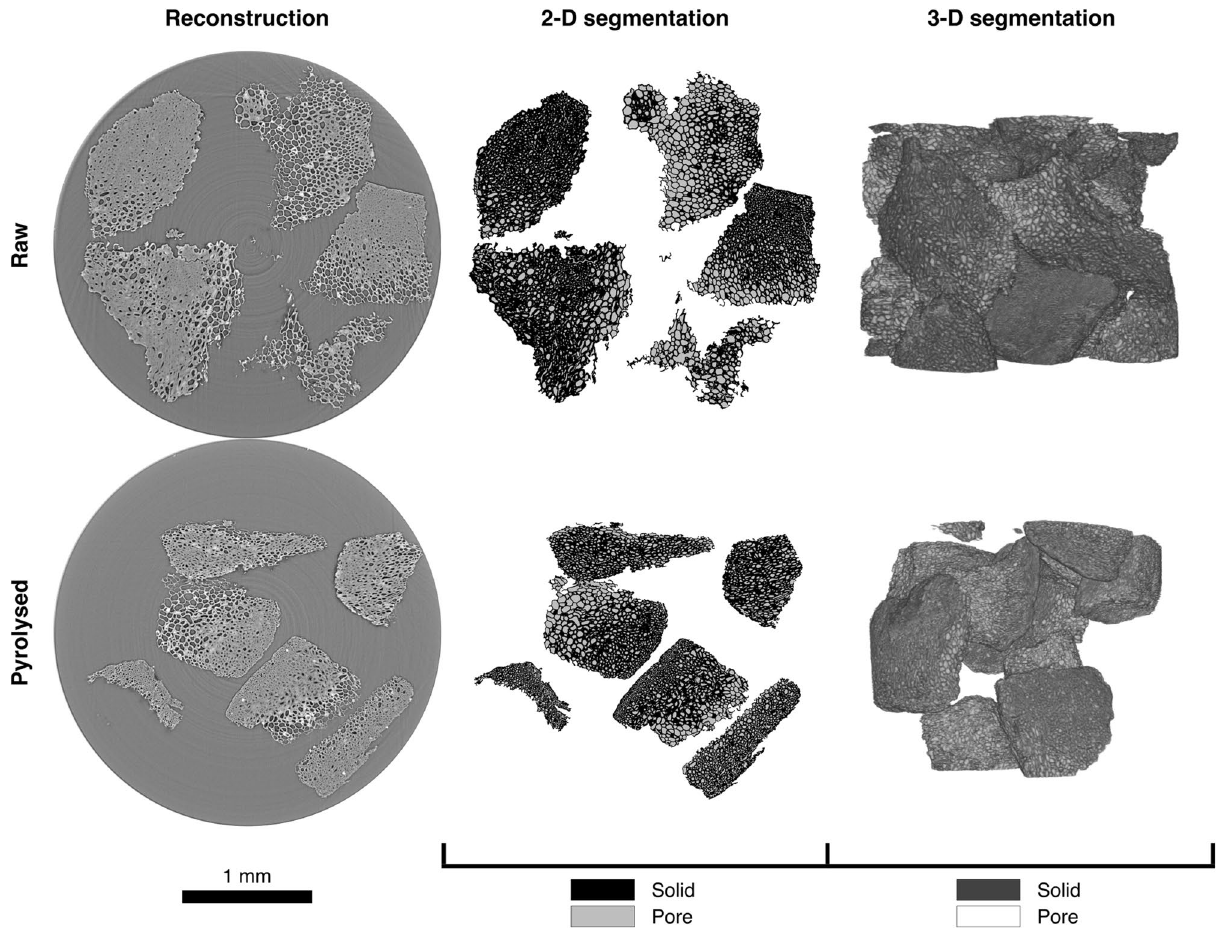
Figure 4. Reconstructed and segmented tomograms and corresponding three-dimensional (3-D) renderings of raw and pyrolysed water-soaked almond shells. Pyrolysed shells were heated at a rate of 6 °C min −1 to a peak temperature of 450 °C and held for 30 min. In 3-D renderings, the scale bar corresponds to the frontmost surface were calculated. Voxels identified as pore space were grouped into individual pores using a 6-way pixel connectivity rule—that is, only pixels touching at a surface were considered connected. Pore locations were